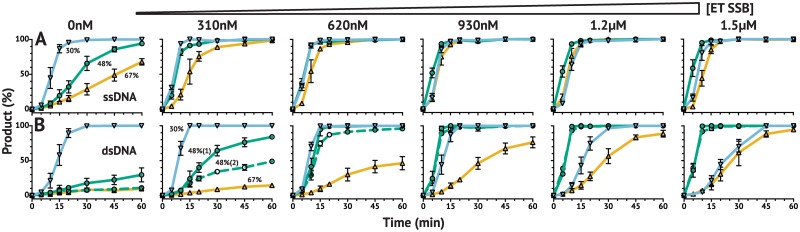
Effect of ET SSB on TtAgo activity in vitro using 17 nt guides.Experiments shown in Fig 2 were repeated with more optimal 17 nt guides and expanded to include dsDNA substrates of 30%GC and 67%GC content, as well as a second dsDNA substrate of 48%GC content containing different fluorescent dye-labels (see S2 Table). The addition of ET SSB allowed for equivalent TtAgo activity on ssDNA and dsDNA substrates with GC contents ranging from 30–70%. (A) shows TtAgo activity on ssDNA substrates over increasing concentrations of ET SSB; corresponding GC contents (▽30%; ○48%; △67%) are labeled in the first panel from the left. (B) shows TtAgo activity on dsDNA substrates over increasing concentrations of ET SSB; corresponding GC contents (▽30%; ○48%; △67%) are labeled in the second panel from the left, and the alternate 48%GC content substrate is represented by the solid green line to adhere to the labeling of Fig 2. Percent product was determined as the ratio of product to substrate monitored by CE throughout the reaction.